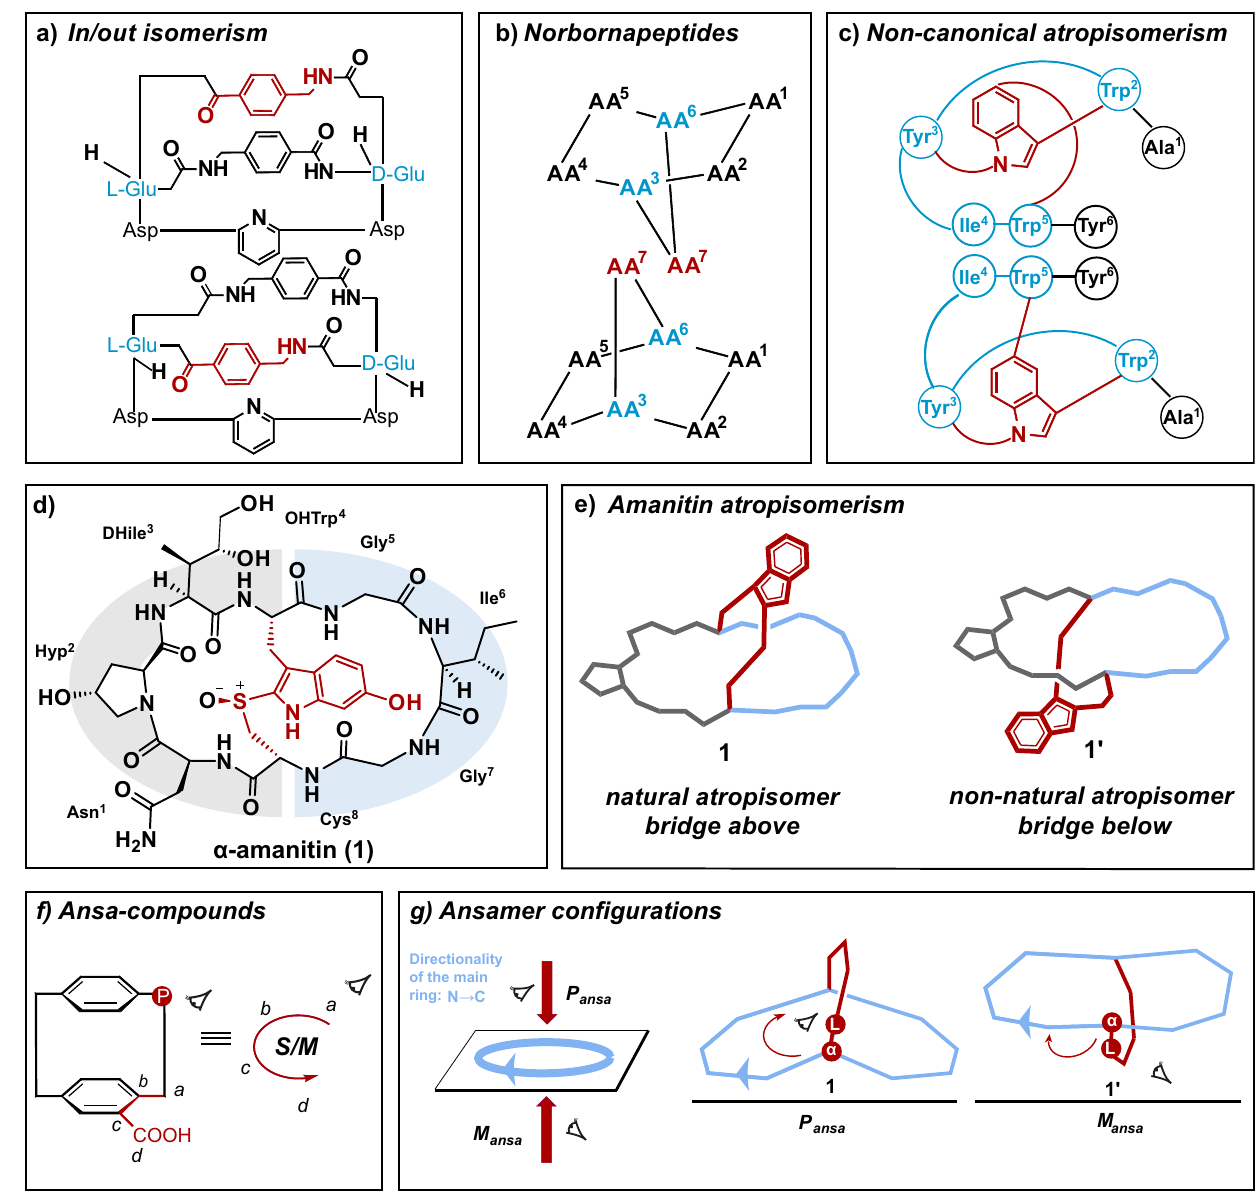
Fig. 1 | Peptide isomerism types and suggested determination of the ansamer con fi guration of cyclic amanitin-type systems. Several nomenclatures have been proposed to describe the isomerism of peptides displaying ring systems ( a – c ). d Structure of α -amanitin with the tryptathionine bridge highlighted in red. DHIle (2 S ,3 R ,4 R -dihydroxyisoleucine), Hyp (4- trans -L-hydroxyproline),OHTrp (6- OH-tryptophan). e Proposed conformational isomers of α -amanitin. The A and B-rings are colored in gray and blue, respectively. f Determination of the